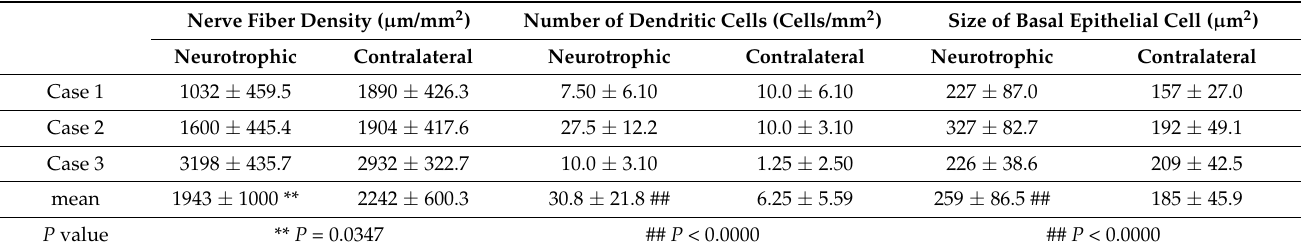
Table 2. Comparison of both corneas by IVCM (analysis of variance: ANOVA).